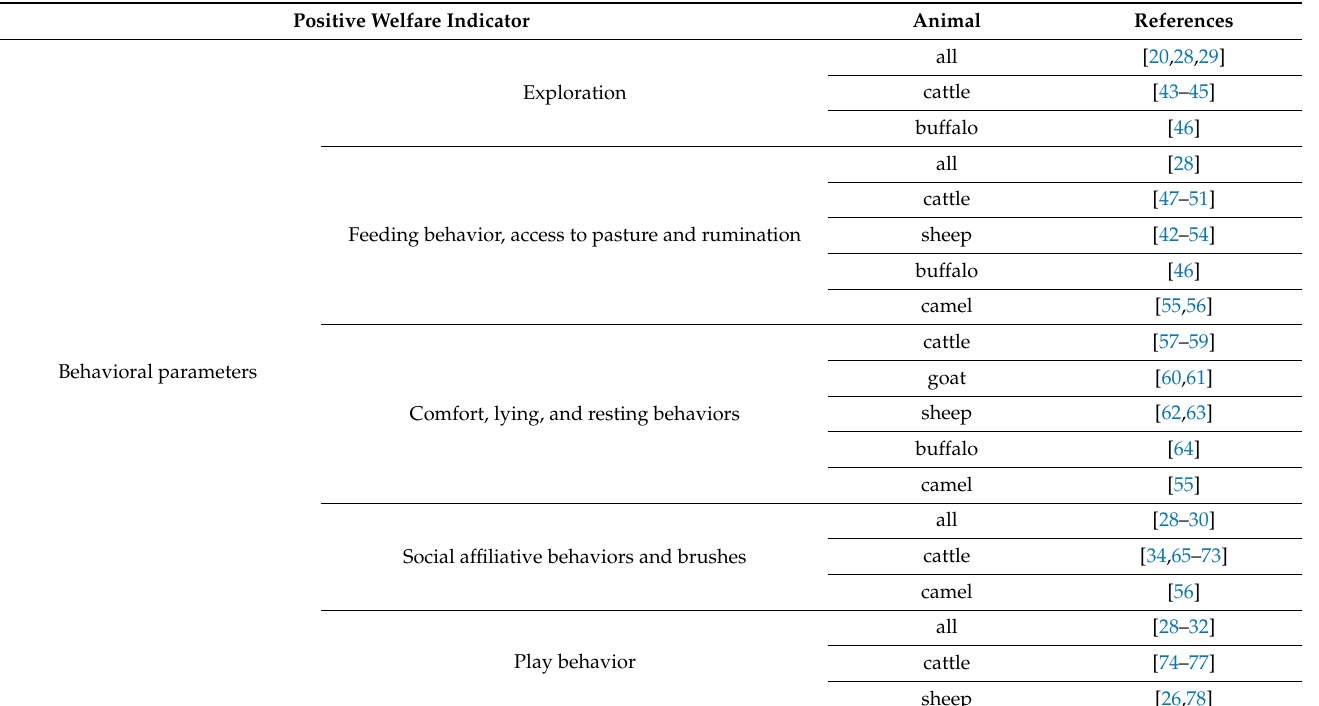
Table 1. Positive welfare indicators categorized by dairy